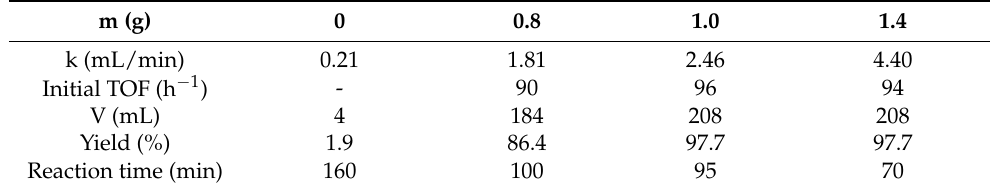
Table 3. Effect of catalysts (Ni/Pd = 20/1) amount for the hydrolysis of DMAB. m (g)